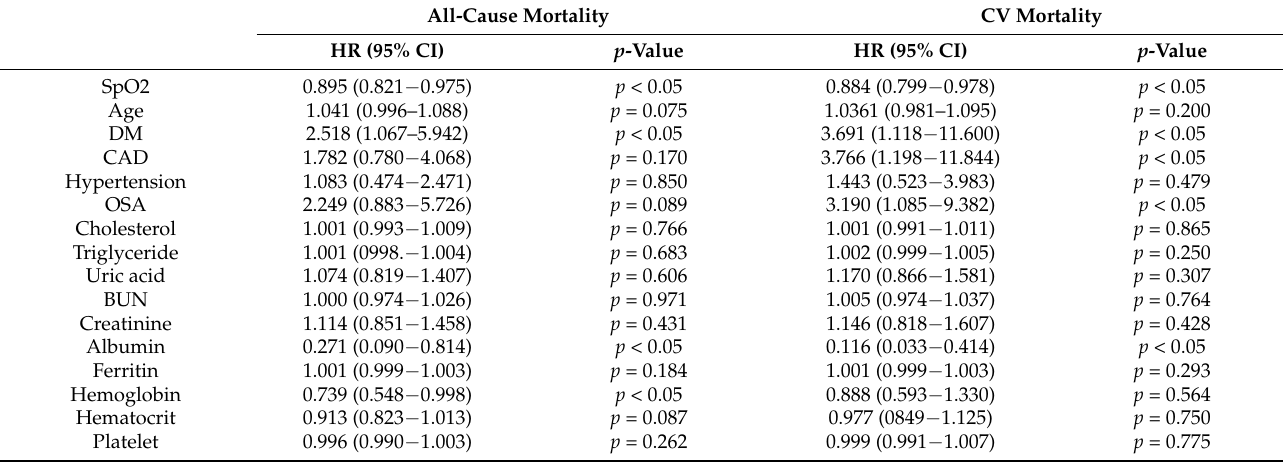
Table 4. The univariate Cox regression model for all-cause and CV mortality with respect to various prognostic factors.